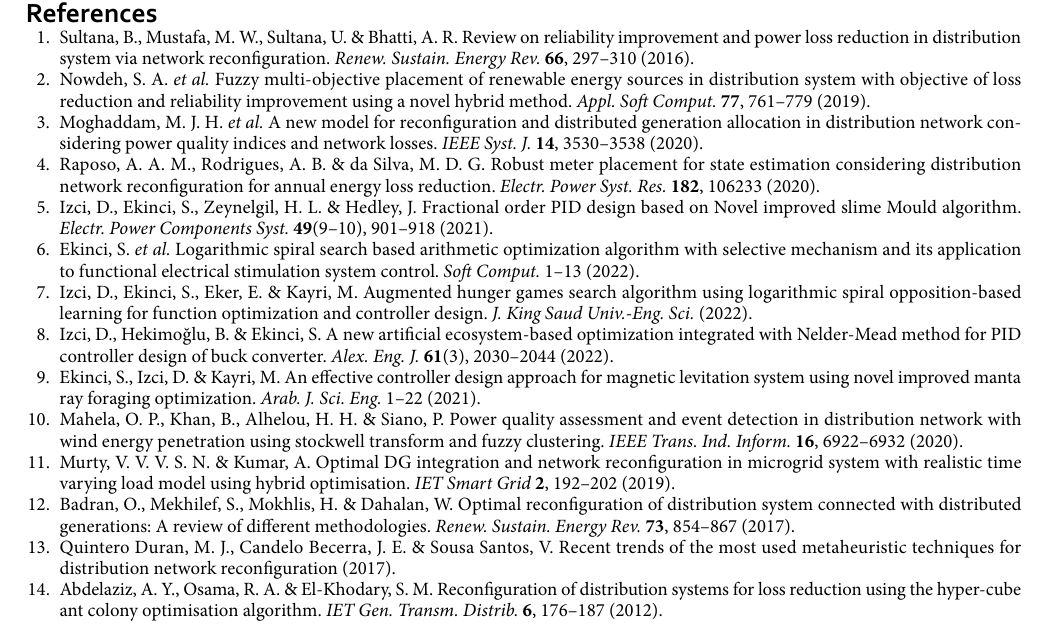
Table 11. Results of balanced and unbalanced 118-bus network reconfigurations with active loss minimization.